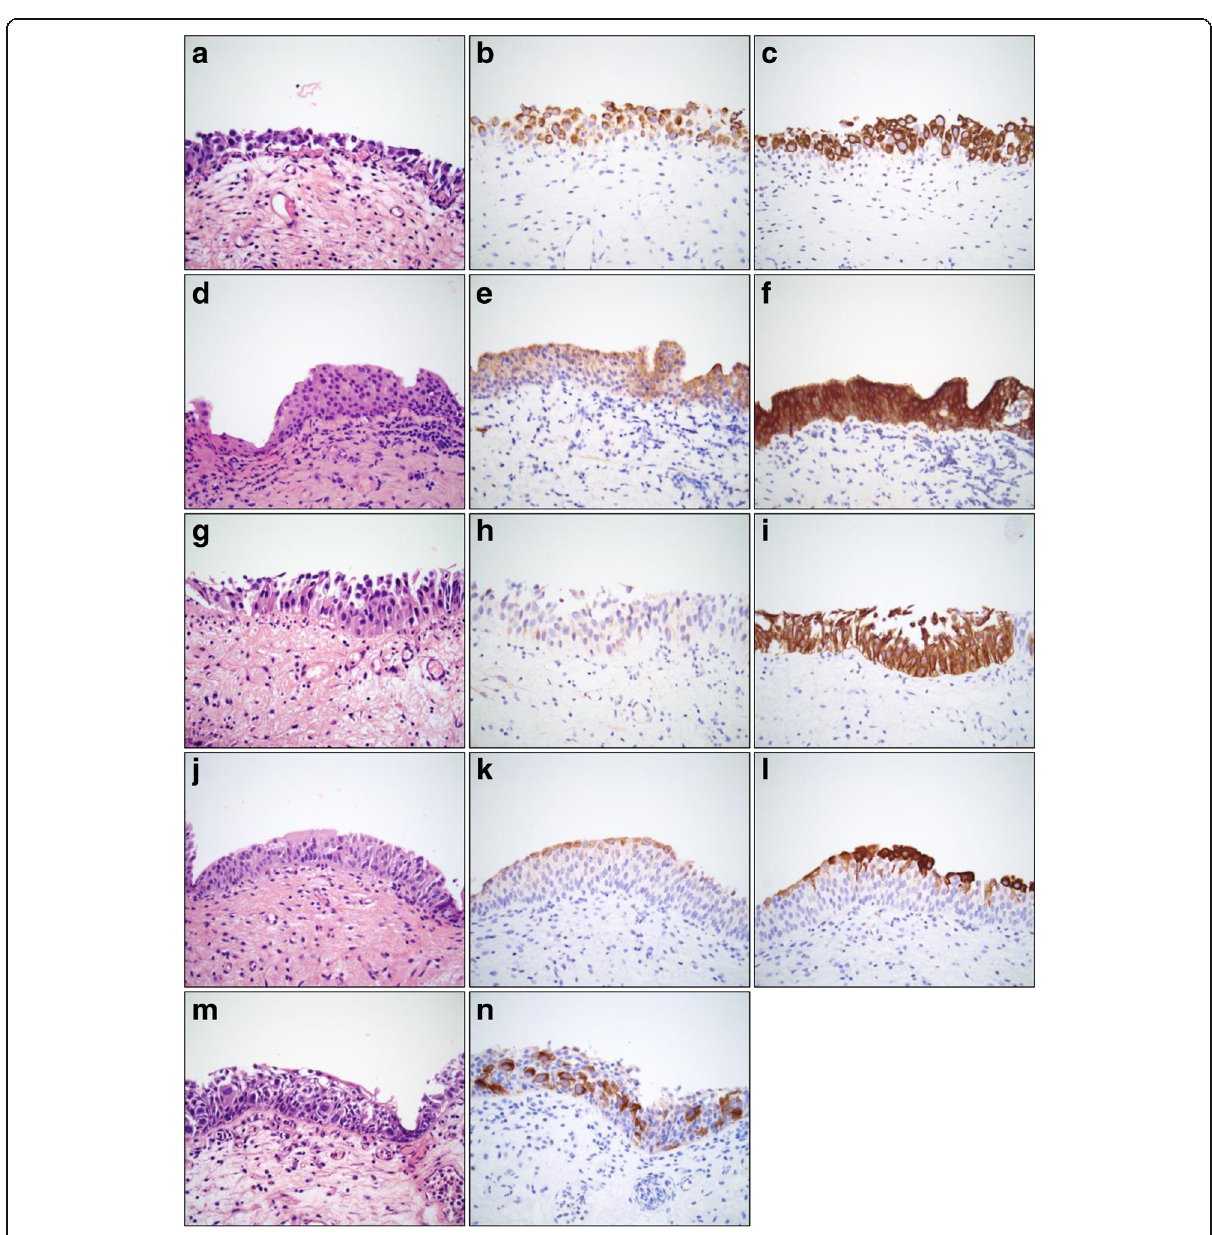
Fig. 1 Photomicrographs of urothelial carcinoma in situ (CIS) and non-neoplastic urothelium (all images × 400 magnification). a-c , CIS that was equivocal on H&E ( a ) showing strong, transurothelial expression with AMACR ( b ) and CK20 ( c ). d-f , CIS equivocal on H&E ( d ) with transurothelial, moderate intensity staining with AMACR ( e ) and transurothelial, strong staining with CK20 ( f ). g-i , CIS equivocal on H&E ( g ) with minimal AMACR expression ( h ) yet transurothelial, strong CK20 expression ( i ). j-l , Non-neoplastic urothelium on H&E ( j ) with surface AMACR expression ( k ) and surface CK20 expression ( l ). m-n , Pagetoid urothelial CIS on H&E ( m ) showing staining of malignant cells with AMACR within a background of non-neoplastic urothelium that is negative for AMACR ( n